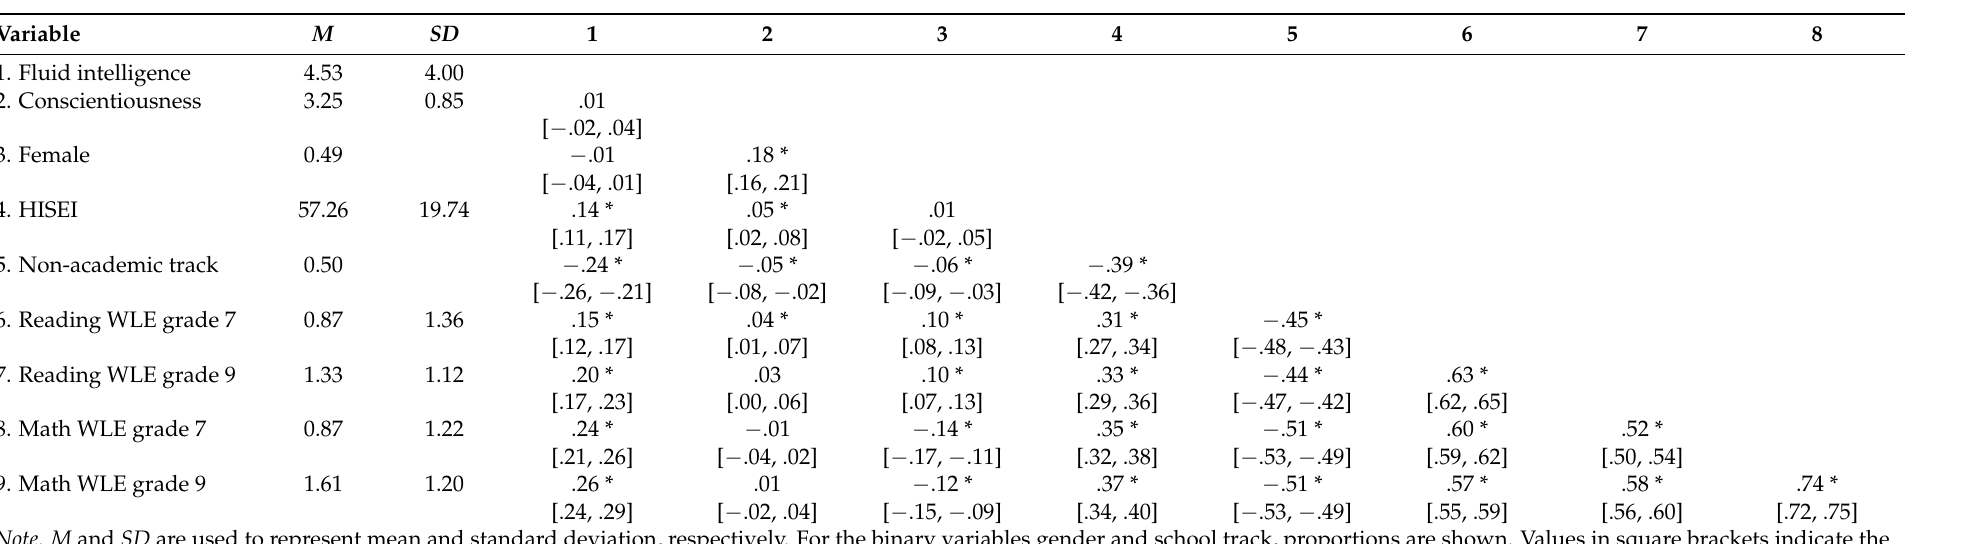
Table 2. Means, standard deviations, and correlations of